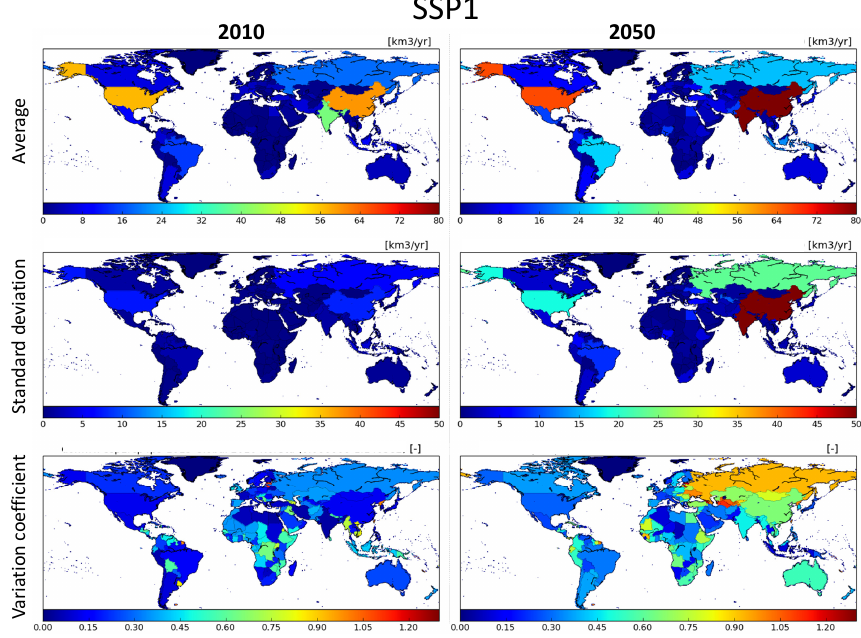
Figure A3. Global maps of projected domestic water withdrawals calculated by the global water models H08, PCR-GLOBWB, and Wa- terGAP for the years 2010 and 2050, respectively, under the SSP1 scenario. Avr, Std, and Std/Avr denote average, standard deviation, and coefficient of variations (CV).